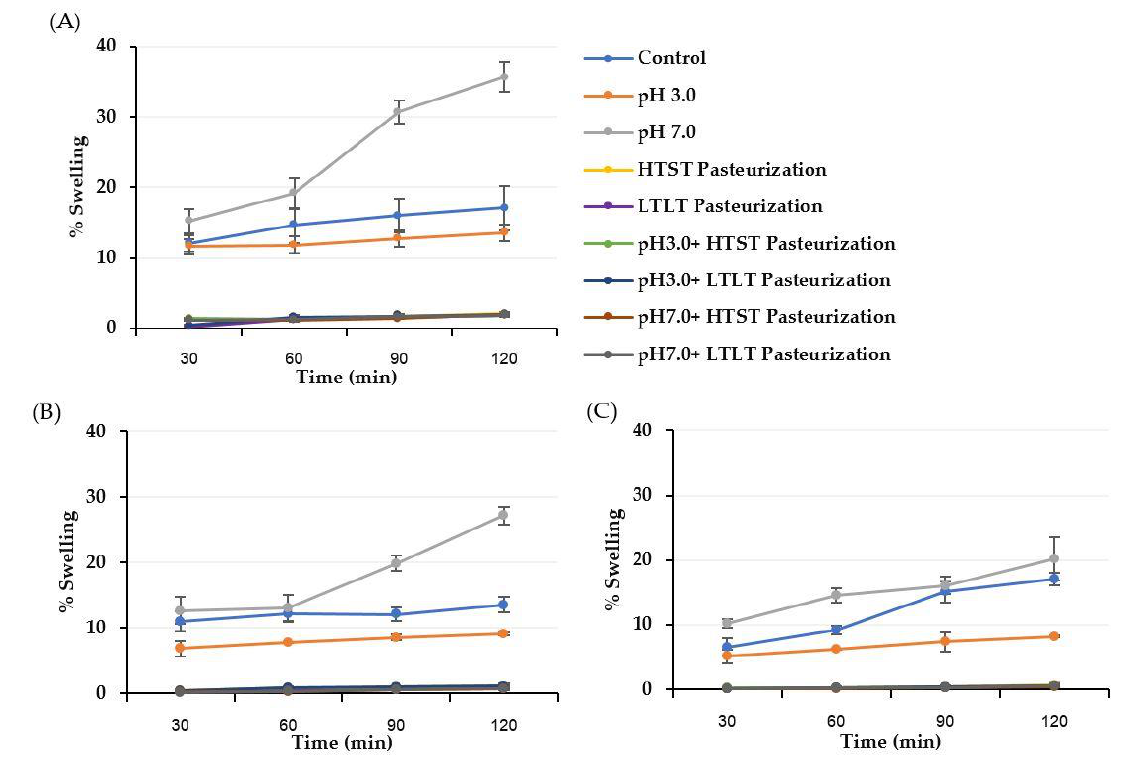
Figure 3. % Swelling of treated CA ( A ), CM ( B ), and CI ( C ) hydrogel beads under SIF. The positive swelling percentage indicates swelling behavior after the treatment. The error bars indicate the SD of the data.